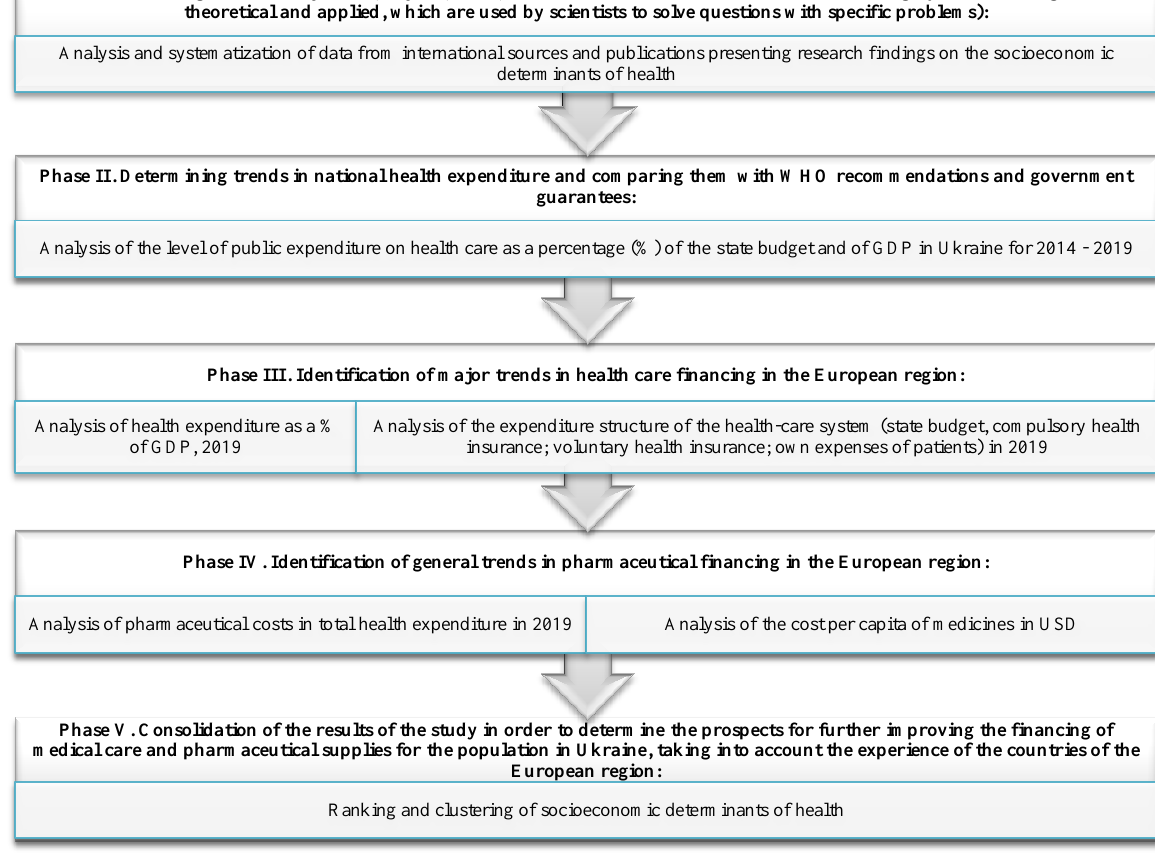
Fig. 1. Algorithm for conducting a comparative analysis of indicators that determine the effectiveness of socio- economic determinants of healthcare in Europe and